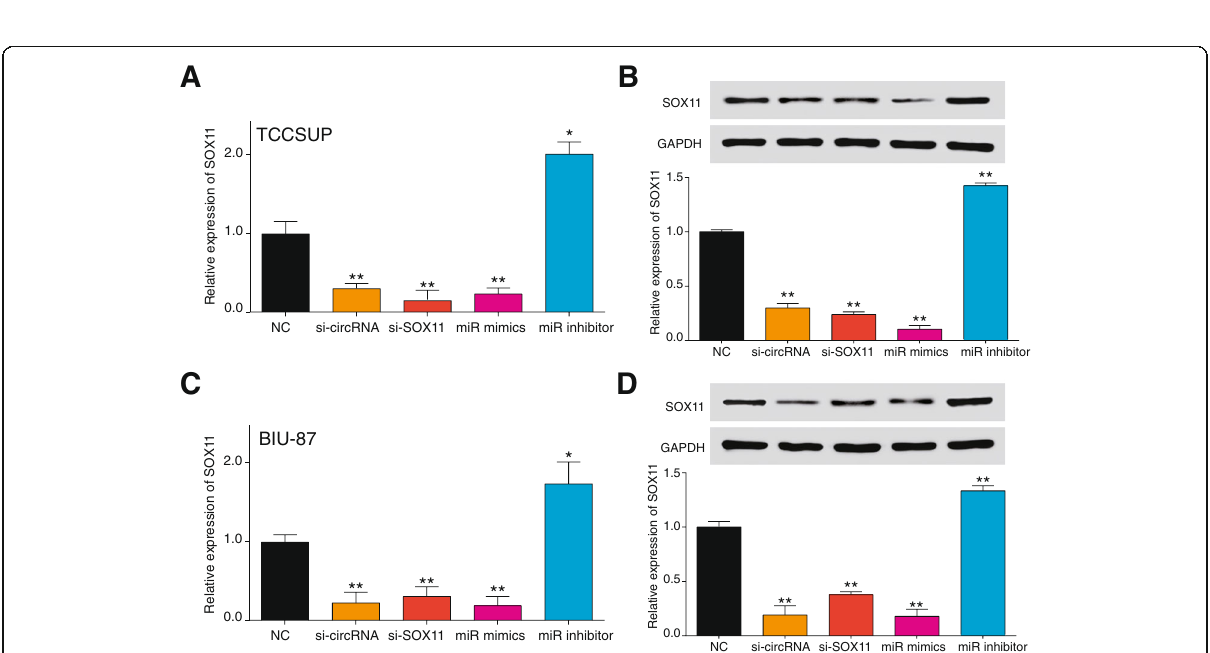
Fig. 5 Knockdown of circCEP128 inhibits expression of SOX11 . The expression levels of SOX11 were detected following knockdown of circCEP127 using si-circCEP128, miR-145-5p inhibitor, co-transfection with si-circCEP128 and the miR-145-5p inhibitor or si- SOX11 ( a ) in TCCSUP and ( c ) in BIU-87. ** P < 0.01, compared with NC. SOX11 protein relative expression levels were analyzed by western blotting ( b ) in TCCSUP and ( d ) in BIU-87. ** P < 0.01, compared with